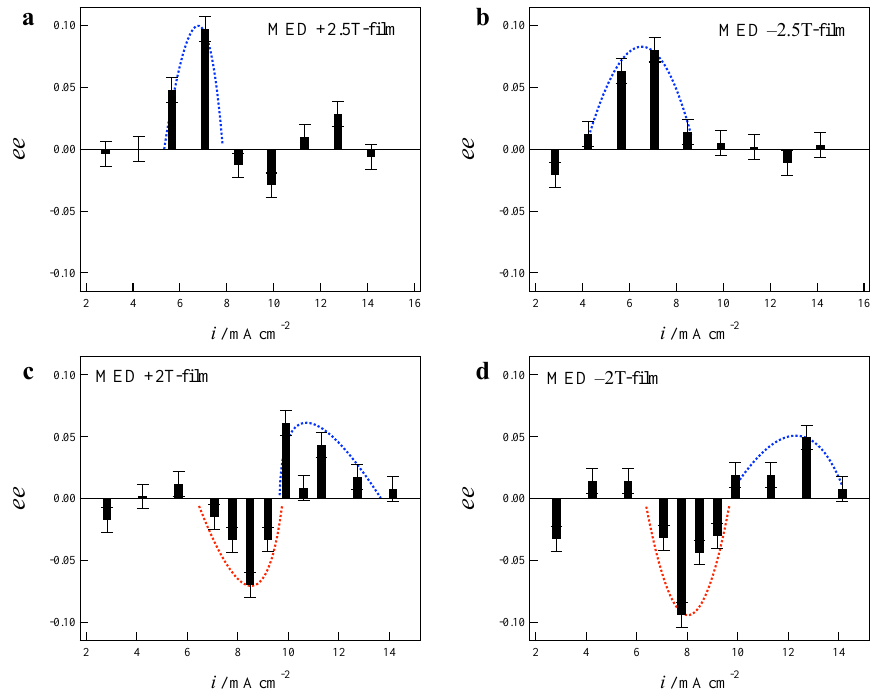
Figure 4. The ee ratios vs. deposition currents. ( a ) MED + 2.5T-film, ( b ) MED − 2.5T-film, ( c ) MED + 2T-film and ( d ) MED − 2T-film. Dotted curves are a guide for the eye.